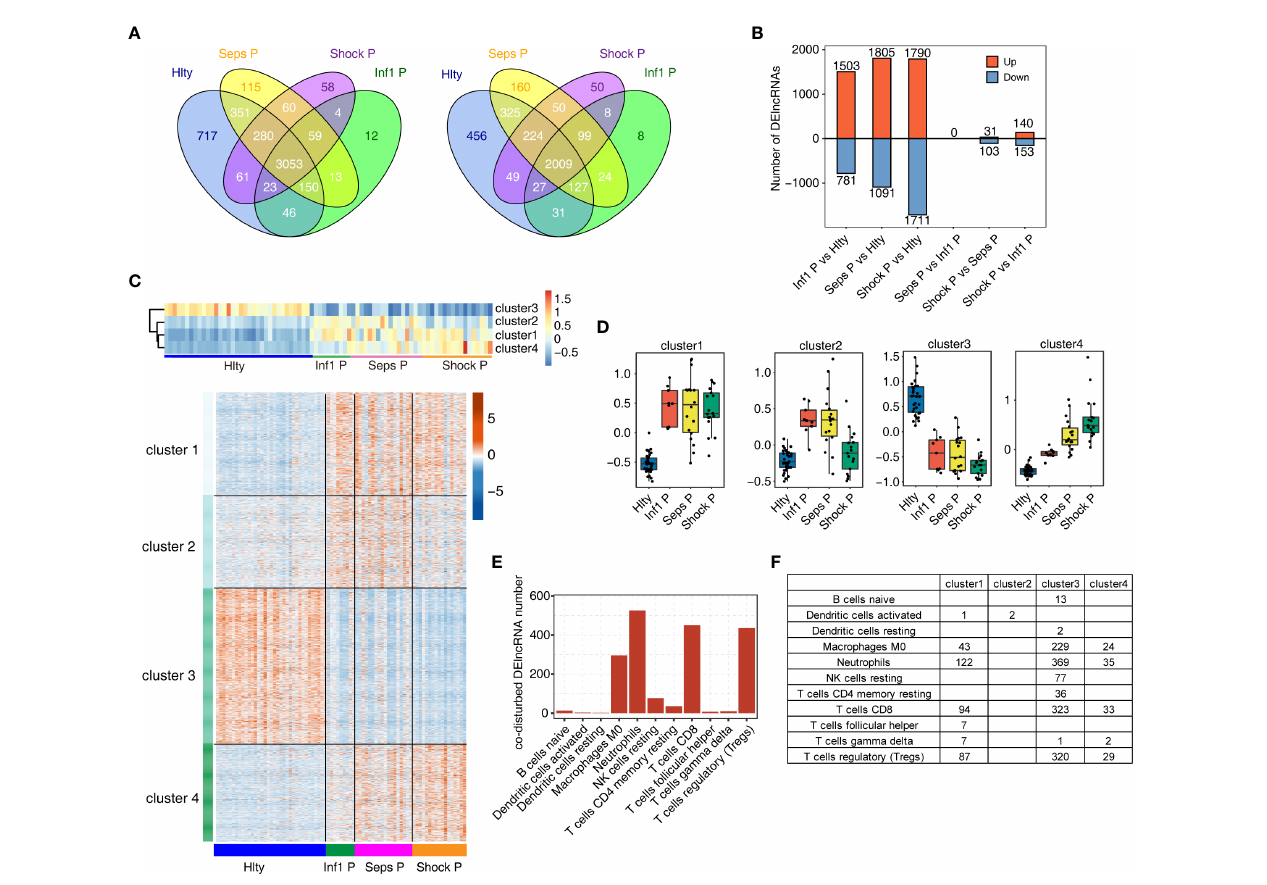
FIGURE 3 Dynamic changes of lncRNA associated with immune microenvironment regulation in healthy donors and sepsis patients with varying degrees. (A) Venn diagram of Known (left) and novel (right) lncRNA genes in Hlty, Inf1 P, Seps P, Shock P. At least two samples with FPKM >= 0.2 is considered to be detected in the group. (B) The number of differentially expressed (DE) lncRNAs among different groups. Bar plot showing the number of up-regulated and down-regulated DElncRNAs. (C) DElncRNAs were clustered using K-means. Heatmap in up-panel presenting 4 clusters of DE lncRNAs identi fi ed by K-means clustering and heatmap in down-panel showing expression patterns according clustered lncRNAs. (D) Boxplot showing cluster centers for k- mean clustering in each sample group. (E) The bar graph showing co-disturbed DElncRNA number of each cell type. (F) The statistical chart showing the distribution of co-disturbed DElncRNA number of each cell type in each